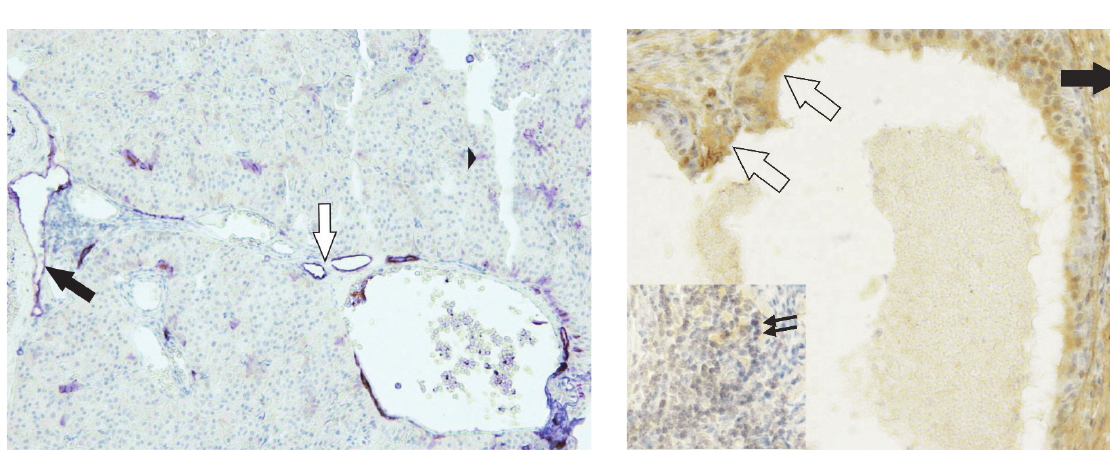
Fig. 4. Warthin’s tumour. Moderate VEGF-C immunoreaction is seen in the nuclei mostly of the inner layer of oncocytic cells (black arrow), some of which also show focally weak staining of the cytoplasma (white arrow). Inset: weak to moderate VEGF-C positivity in the nuclei of stromal lymphocytes (double